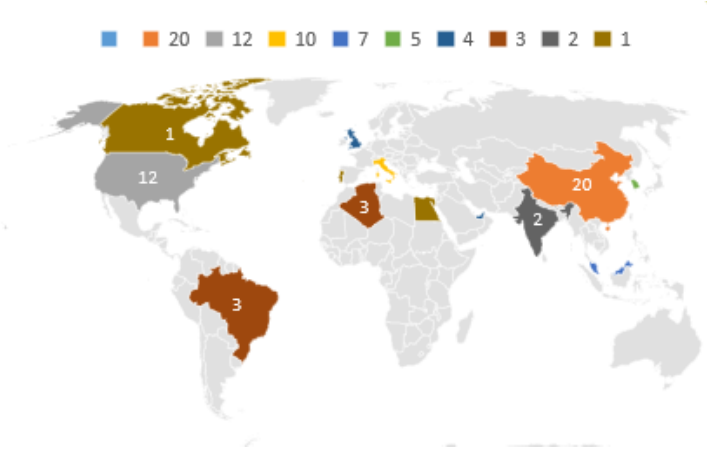
Figure 6. Country distribution.